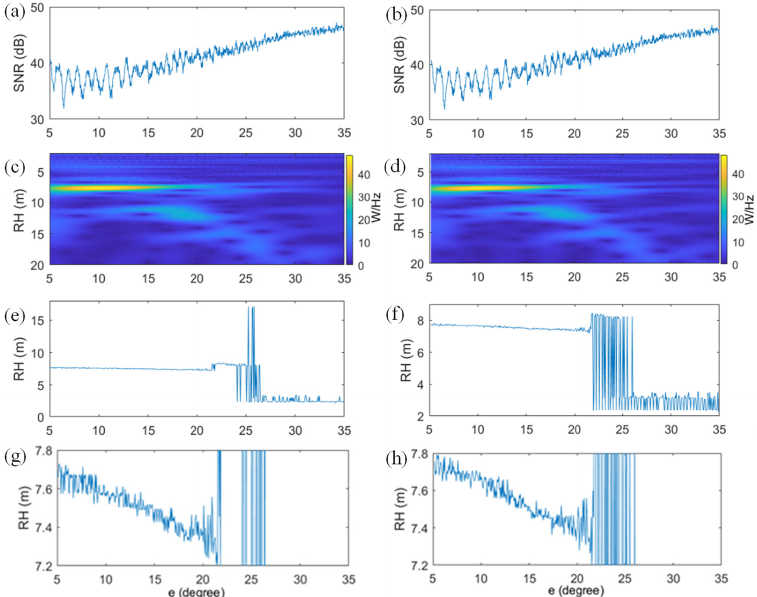
Figure 6. SNR arc, the corresponding wavelet spectrogram, and the corresponding peak RH series with and without elevation bending correction: ( a ) the SNR arc with bending uncorrected elevation of GPS L2C from PRN 3 satellite on DOY 237, 2017; ( b ) the SNR arc with bending corrected elevation of GPS L2C from PRN 3 satellite on DOY 237, 2017; ( c ) the wavelet spectrogram of SNR arc in ( a ); ( d ) the wavelet spectrogram of SNR arc in ( b ); ( e ) the peak RH series of ( c ); ( f ) the peak RH series of ( d ); ( g ) the peak RH series of ( c ) with RH in range of 7.2 m to 7.8 m; ( h ) the peak RH series of ( d ) with RH in range of 7.2 m to 7.8 m.